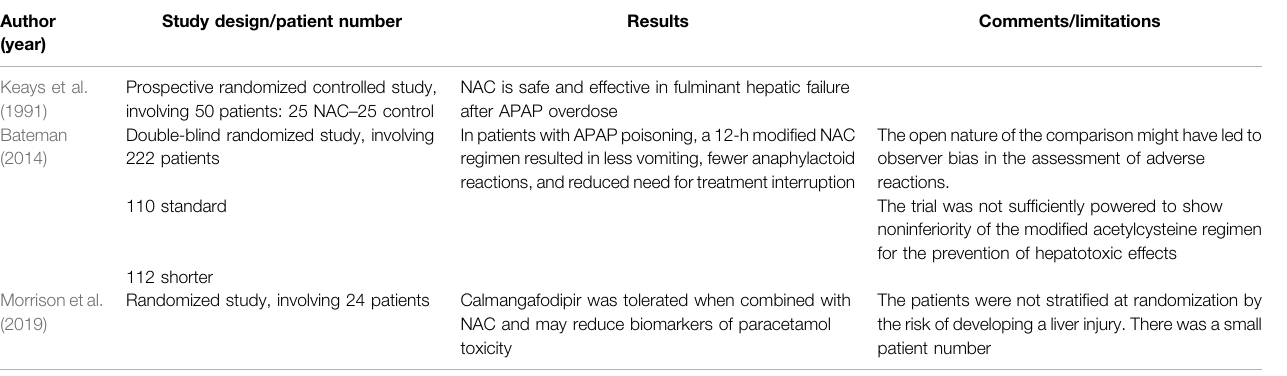
TABLE 6 | Heterogeneity and quality assessment of three clinical trials included in the